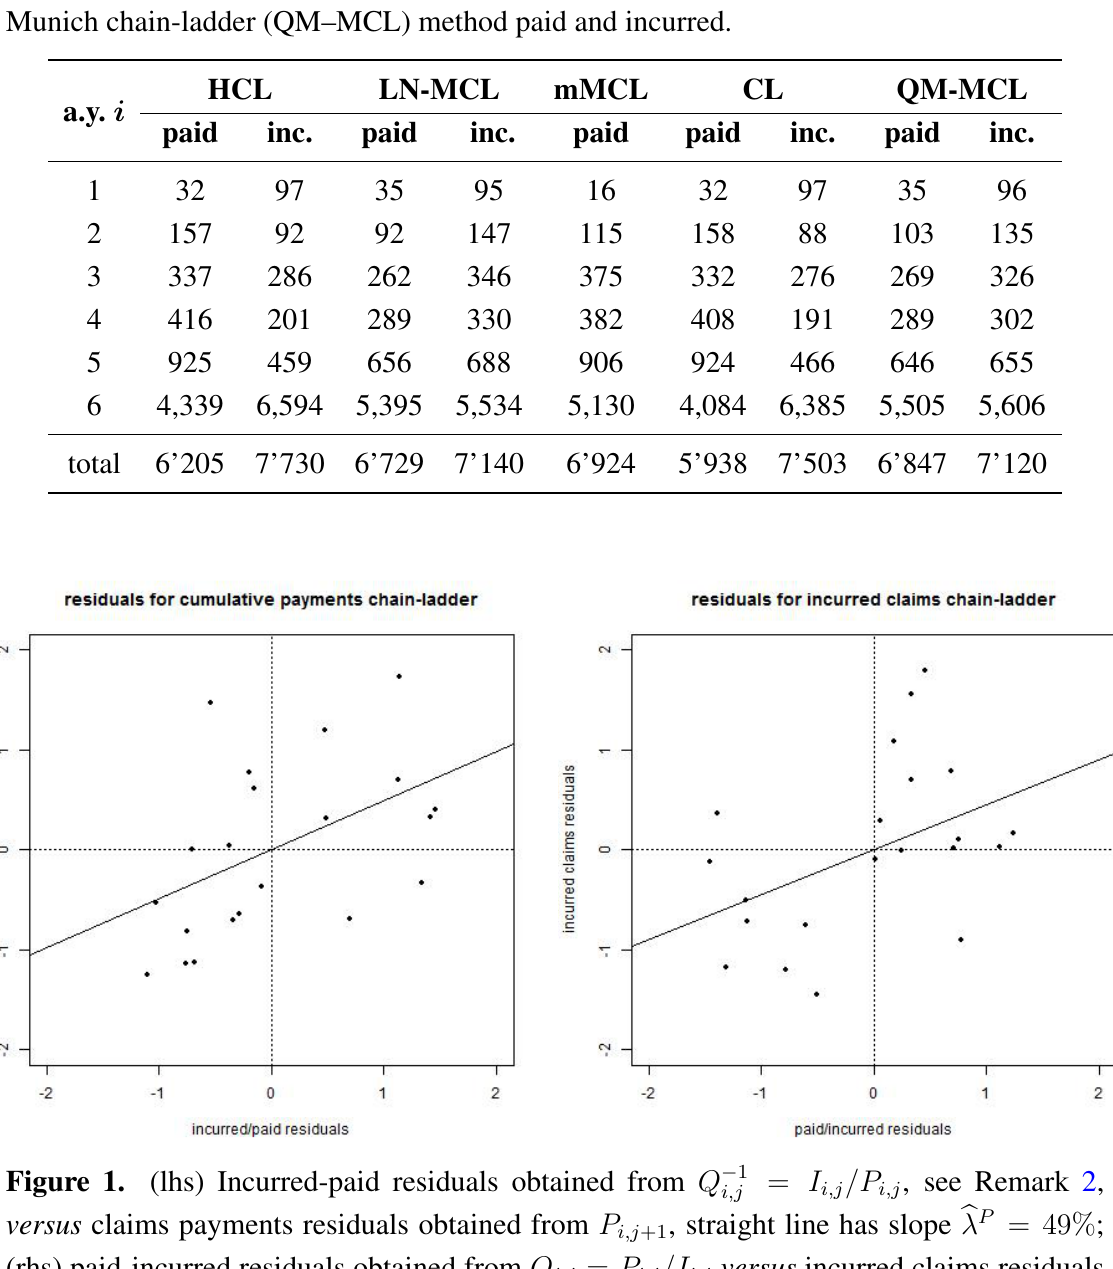
= I /P , see Remark 2, i,j i,j i,j , straight line has slope (cid:98) λ P = 49% ; i,j +1 versus incurred claims residuals = P /I i,j i,j i,j